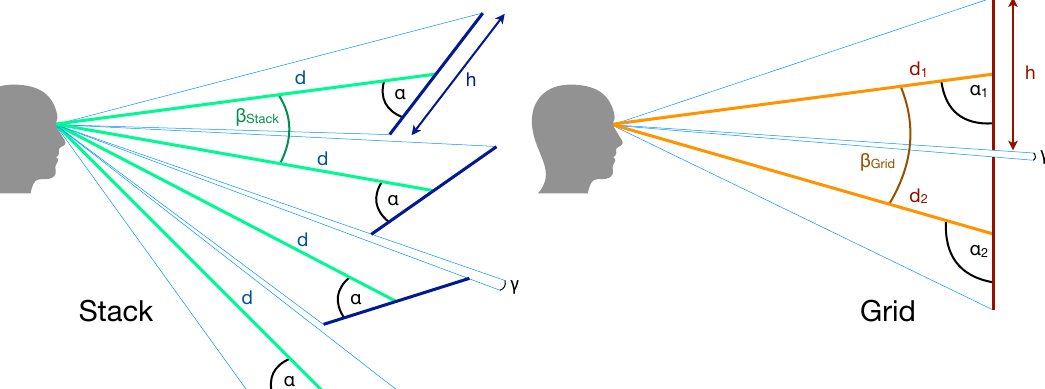
Figure 2. Spatial arrangement of the layers in the stack and grid systems, as seen from the side, highlighting the larger visual distance ( β ) between layers in the grid, assuming same height ( h ) of the maps, same minimum distance to viewer ( d 1 ), and same gap between layers ( γ ). The viewing angles ( α ) and distances ( d ) are constant in the stack and different in the grid, depending on viewer